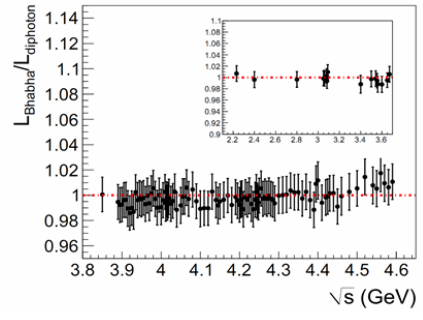
Figure 1. The ratio ratios of integrated luminosity measured by e + e − → ( γ ) e + e − and e + e − → ( γ ) γγ